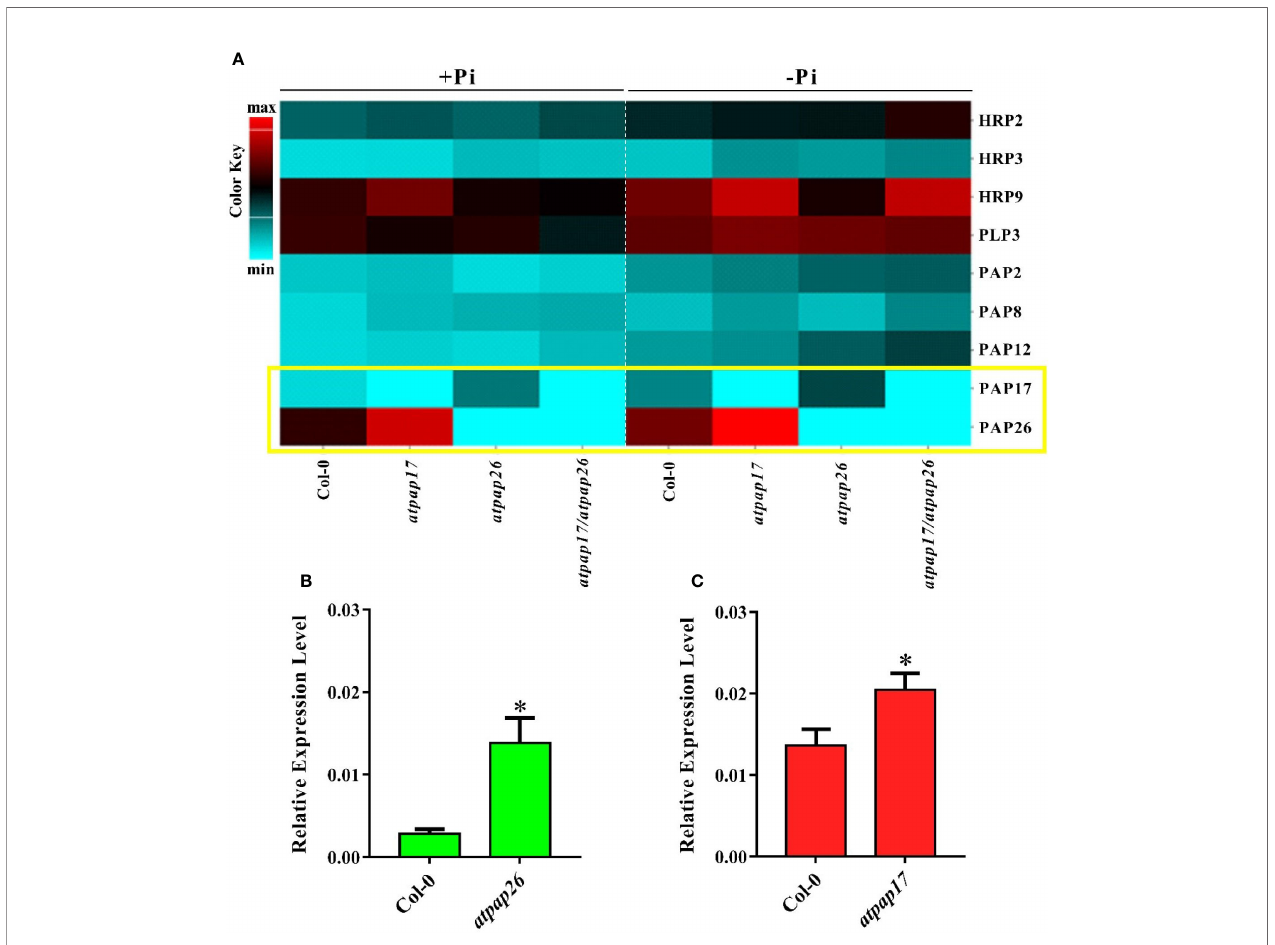
FIGURE 5 | Heat map of expression pattern of some APase genes in Col-0, atpap17 , atpap26 , and atpap17/atpap26 mutants grown under Pi-suf fi cient (+Pi, 1.25 mM KH 2 PO 4 ) and − Pi (no Pi) conditions (A) . Real time PCR analysis of the expression of AtPAP17 (B) and AtPAP26 (C) in +Pi seedling of Col-0, atpap26 and atpap17 mutants. Total RNA was extracted from 21-day-old plants with three biological replicates. Asterisks (*) indicate values that are signi fi cantly different from that of the